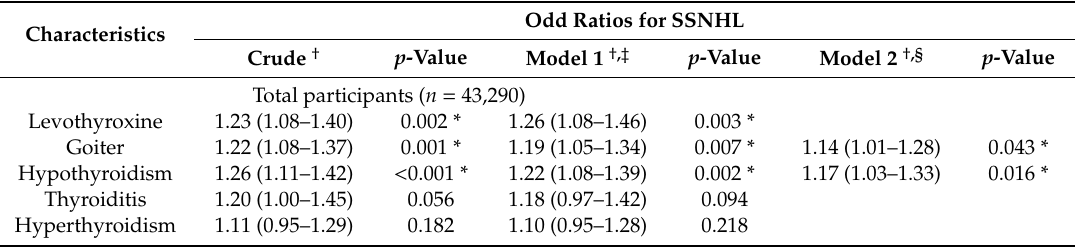
Table 2. Crude and adjusted odd ratios (95% confidence interval) for SSNHL in levothyroxine, goiter, hypothyroidism, thyroiditis, and